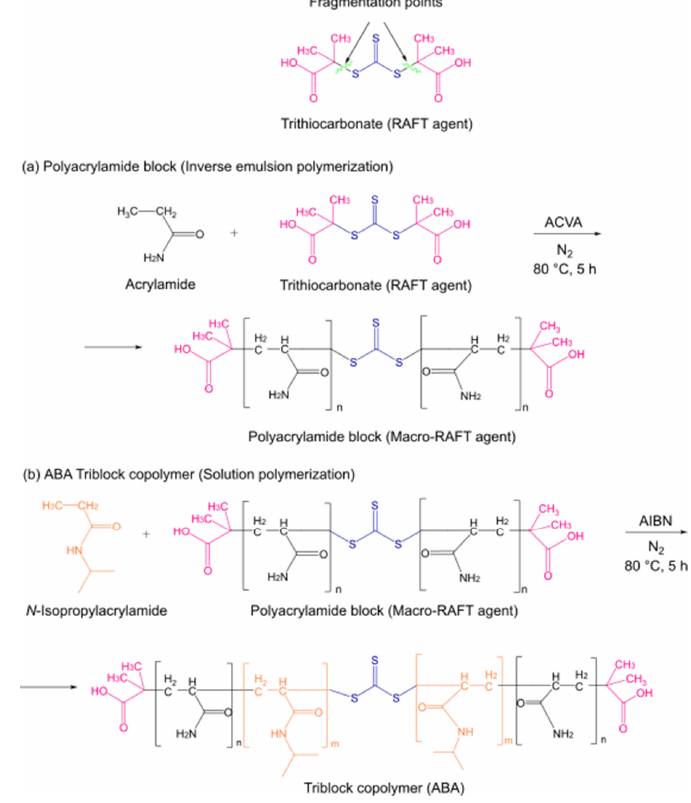
Figure 1. Representation of the two-step synthesis of triblock copolymers via thermally induced reversible addition–fragmentation chain-transfer polymerization (RAFT): ( a ) synthesis of the PAM block or macro-RAFT agent; ( b ) synthesis of the ABA triblock copolymers (PAM- b -PNIPAM- b -PAM). The structural characterization of these triblock copolymers was carried out by FTIR spectroscopy and proton nuclear magnetic resonance ( 1 H NMR). According to FT-IR, the three copolymers displayed the characteristic bands of both the PAM and PNIPAM blocks, as Figure 2 shows. However, the main di ff erence between the spectra was the band intensity of each block due to the fact that each copolymer was composed of di ff erent proportions. The polyacrylamide blocks exhibited the N–H 2 vibrations of the primary amide at 3400 cm − 1 and 3200 cm − 1 . The band of the CH 2 backbone was at 2980 cm − 1 . In addition, the C=O stretching vibration bands of the amide group were at 1645 cm − 1 and 1603 cm − 1 . The block of PNIPAM, on the other hand, presented the N-H vibration of the secondary amide at 3294 cm − 1 . The vibrations of the isopropyl group were located at 2972 and 2926 cm − 1 . In addition, the bands of the C=O stretching and N bond to the isopropyl group of the secondary amide were at 1641 cm − 1 and 1536 cm − 1 .